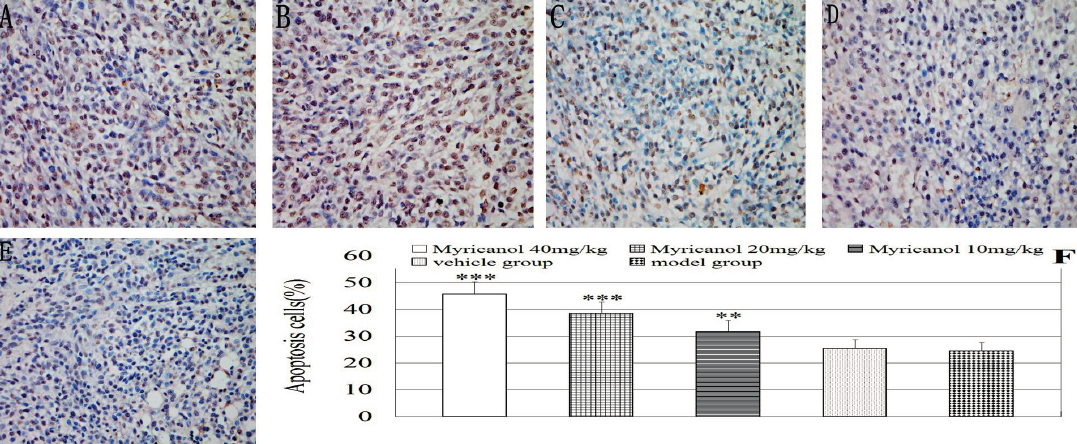
Figure 9. TUNEL staining in an A549 xenograft mouse model (magnification, ×400). ( A ) Myricanol with 40 mg/kg; ( B ) myricanol with 20 mg/kg; ( C ) myricanol with 10 mg/kg; ( D ) vehicle control group; and ( E ) tumor model group; ( F )